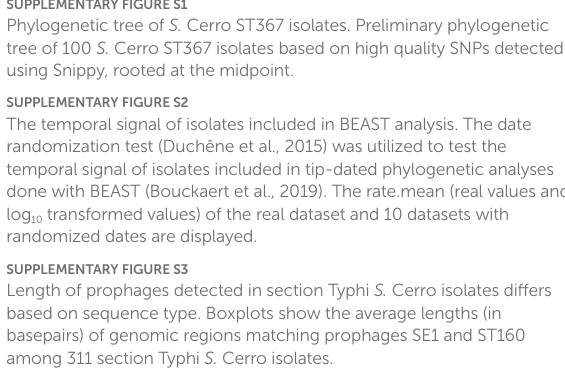
SUPPLEMENTARY FIGURE S1 Phylogenetic tree of S. Cerro ST367 isolates. Preliminary phylogenetic tree of 100 S. Cerro ST367 isolates based on high quality SNPs detected using Snippy, rooted at the midpoint. SUPPLEMENTARY FIGURE S2 The temporal signal of isolates included in BEAST analysis. The date randomization test (Duchêne et al., 2015) was utilized to test the temporal signal of isolates included in tip-dated phylogenetic analyses done with BEAST (Bouckaert et al., 2019). The rate.mean (real values and log 10 transformed values) of the real dataset and 10 datasets with randomized dates are displayed. SUPPLEMENTARY FIGURE S3 Length of prophages detected in section Typhi S. Cerro isolates differs based on sequence type. Boxplots show the average lengths (in basepairs) of genomic regions matching prophages SE1 and ST160 among 311 section Typhi S. Cerro